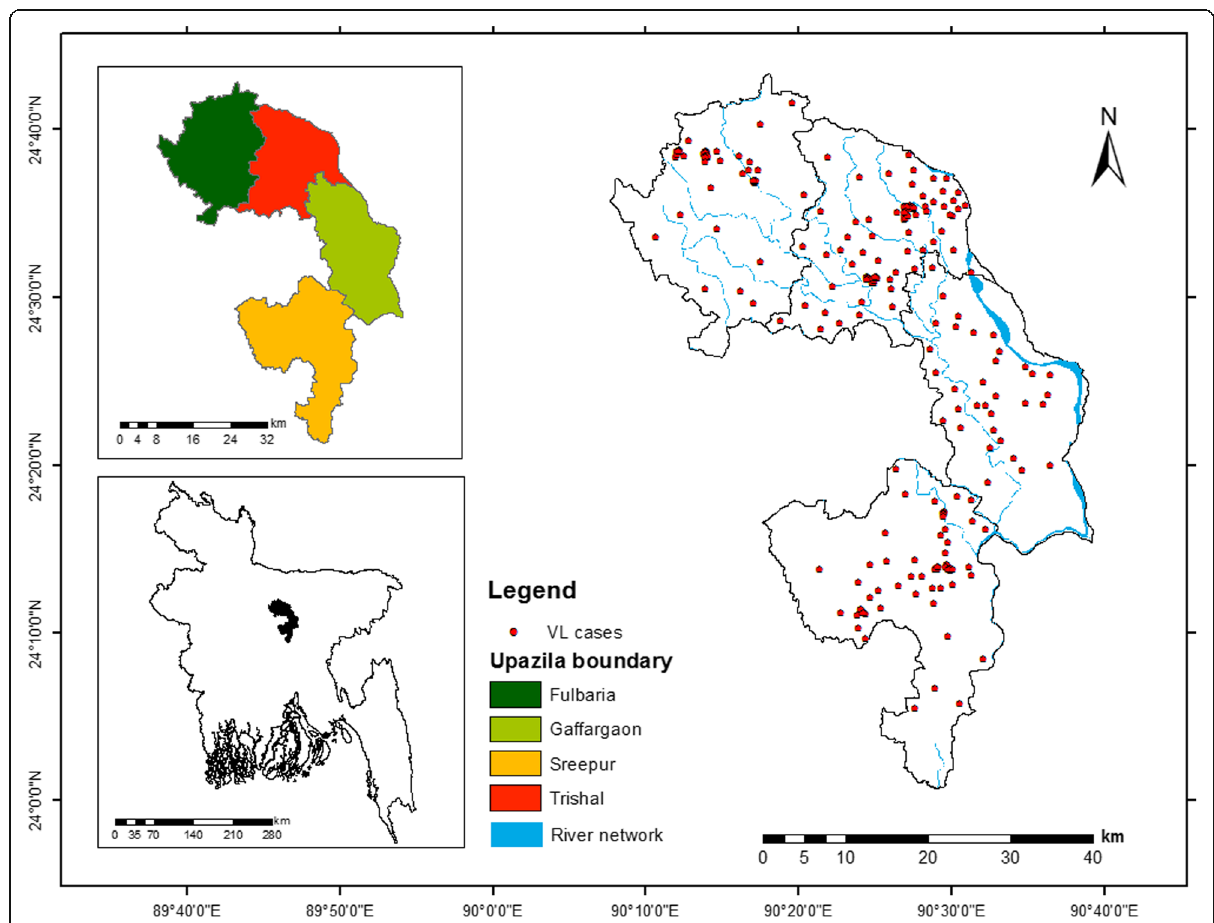
Fig. 1 Location of the study area. Point shapes indicate the observed human VL cases obtained from the